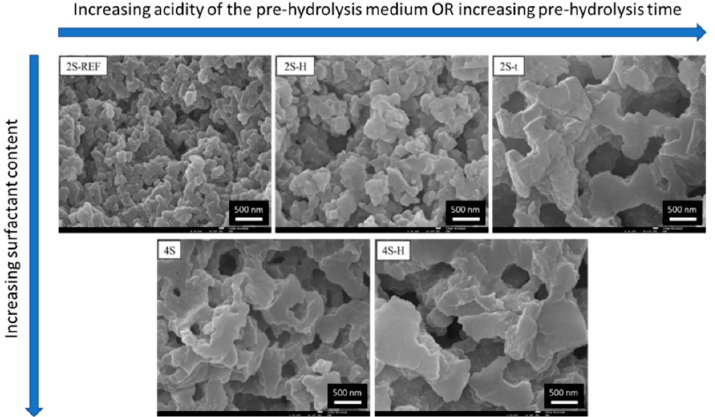
more coarsened domains (increased characteristic sizes). This work suggested that the more viscous silane solution (hydrolysate), the more evolved phase separation, i.e., the more coarsened the siloxane domains are (Figure 28). more coarsened the siloxane domains are (Figure 28).